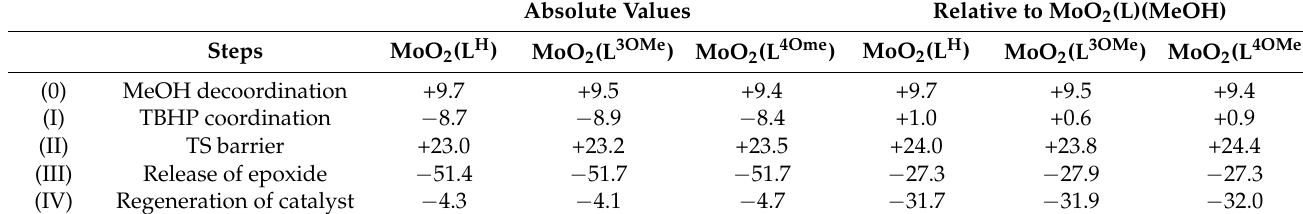
Table 3. Enthalpy values ( ∆ H) (in kcal mol − 1 ) for each step depicted in Scheme 3. Absolute